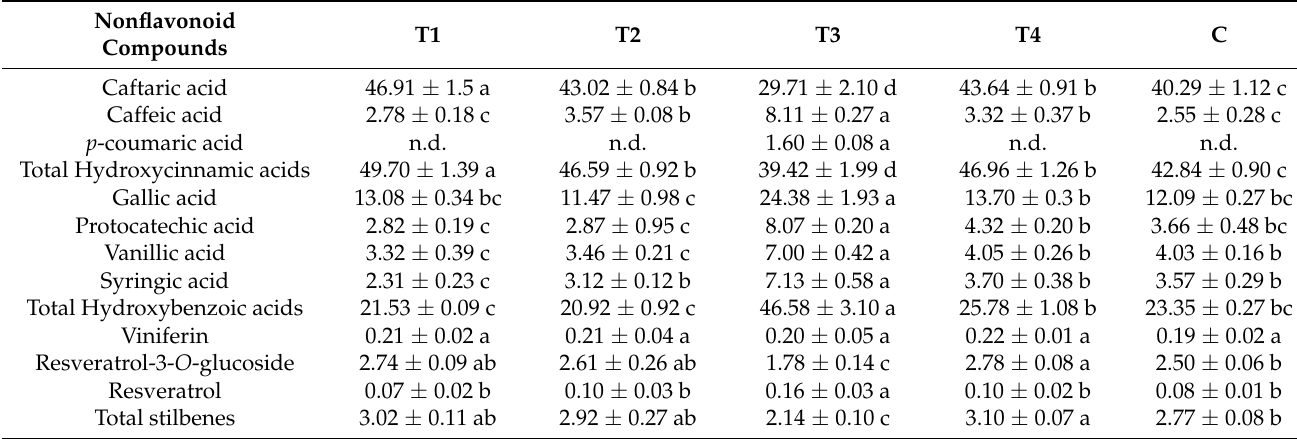
Table 3. Effects of fruit zone leaf removal: preflowering (T1), after berry set (T2), at veraison (T3), cluster thinning without defoliation in veraison (T4) and untreated control (C) on the concentration of nonflavonoid phenolic compounds in Trnjak wines (mg/L).